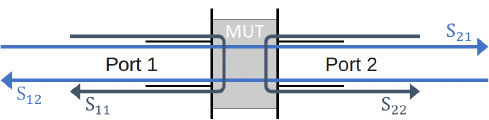
Figure 1. Scheme of the S-parameters in 2-port configuration.